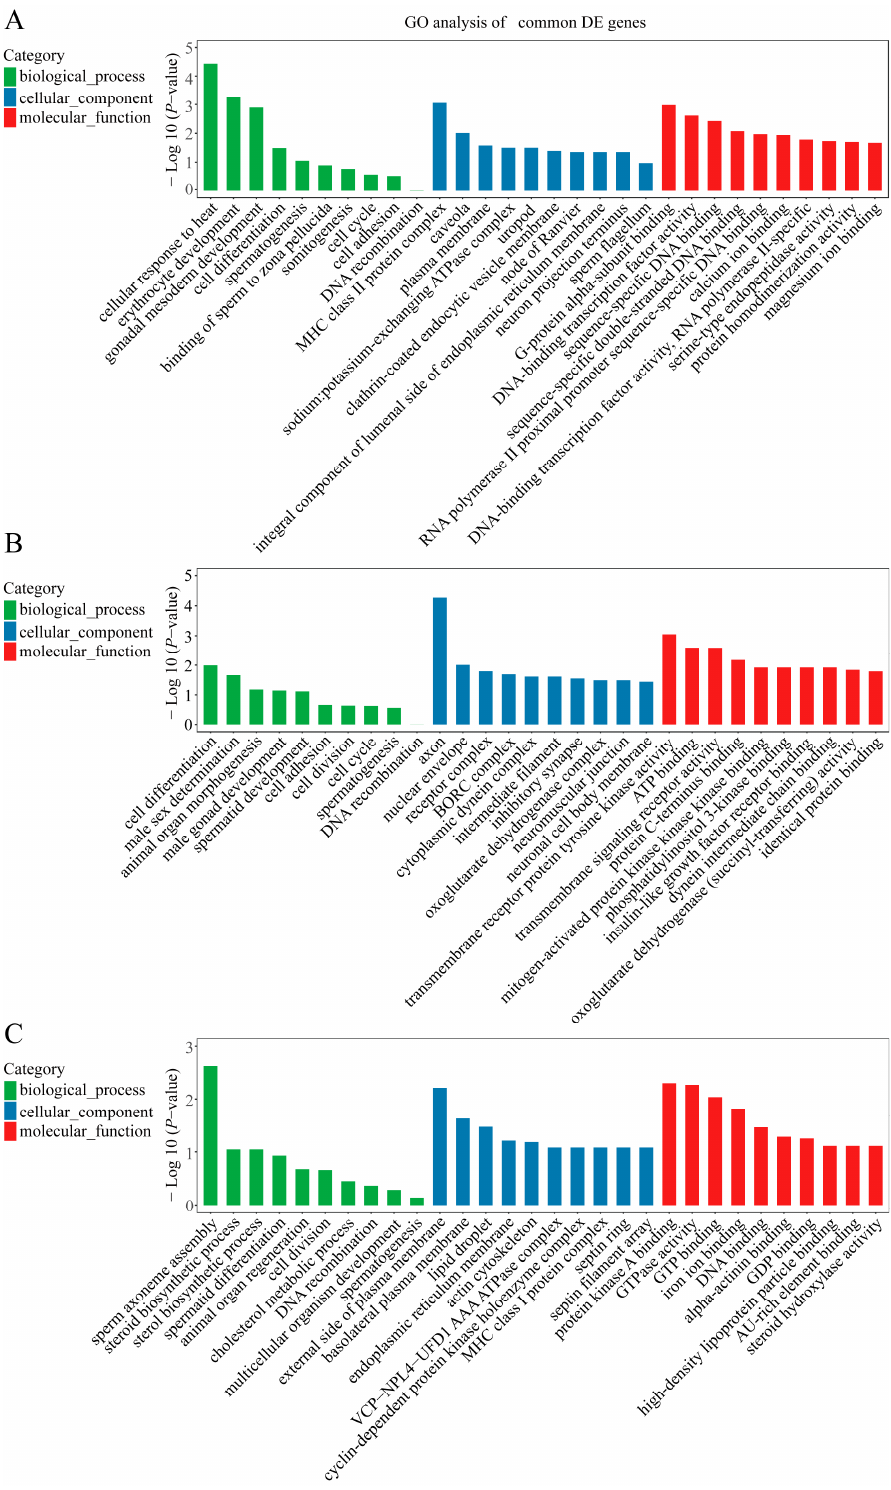
Figure 4. GO analysis of common DE genes. ( A ) GO analysis of common DE mRNAs. ( B ) GO analysis of common DE lncRNAs. ( C ) GO analysis of common DE circRNAs. The top 10 enriched GO terms ranked by p -values are shown ( p -value < 0.05).